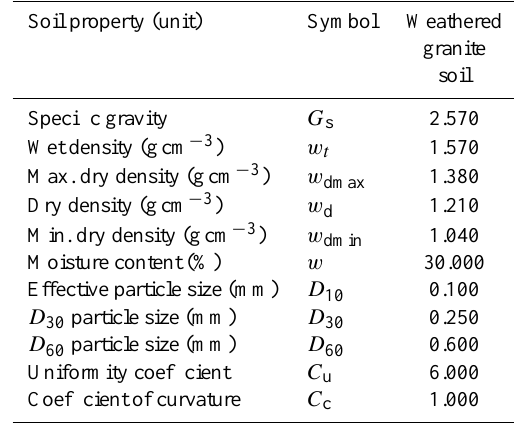
Table 1. Physical properties of the weathered